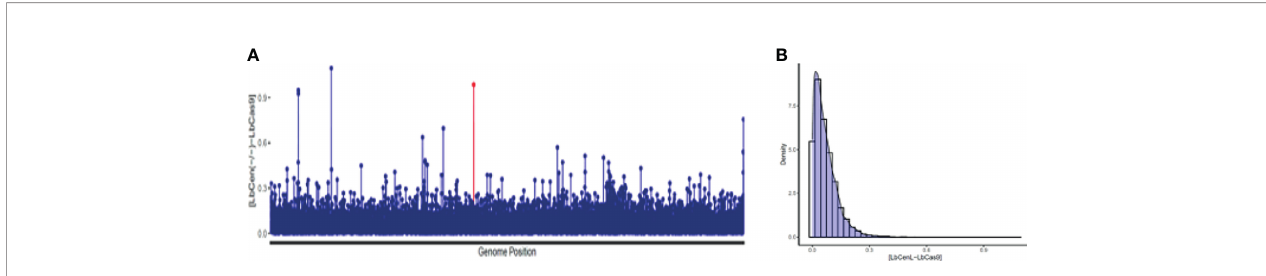
FIGURE 4 | Read depth coverage (RDC) alterations in LbCas9T7 and LbCen − / − . (A) Absolute values of the RDC difference from LbCas9T7 and LbCen − / − genomic libraries in each L. braziliensis gene normalized by genome coverage. Each line of the X axis corresponds to a gene, ordered by its genome position from the smallest to the largest chromosome. The Y axis represents the difference of RDC absolute values for each gene from LbCas9T7 and LbCen − / − lines. The LbrM.22.1290 centrin gene is highlighted in red. (B) Density plot of the RDC differences in LbCas9T7 and LbCen − / − lines. The X axis corresponds to the difference of RDC absolute values of each gene from LbCas9T7 and LbCen − / − lines, the Y axis represents the distribution of occurrence of these values. Most of the differences are below 0.3.